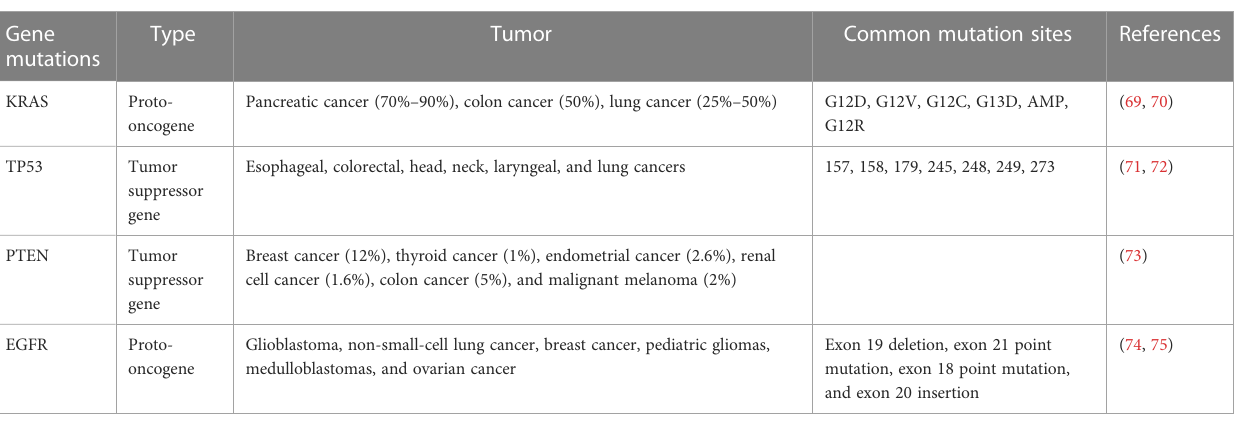
TABLE 2 The type of tumor caused by gene